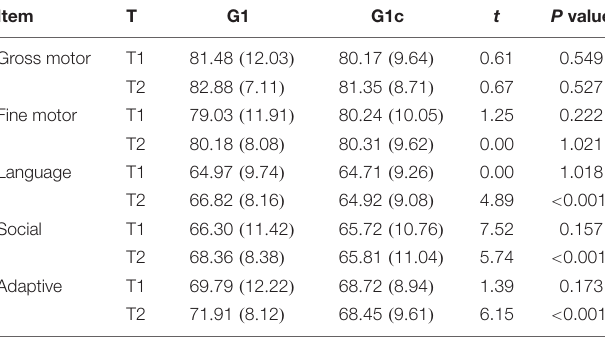
TABLE 3 | Comparison of T1 and T2 scores on the China Developmental Scale for Children between G1 and G1c.